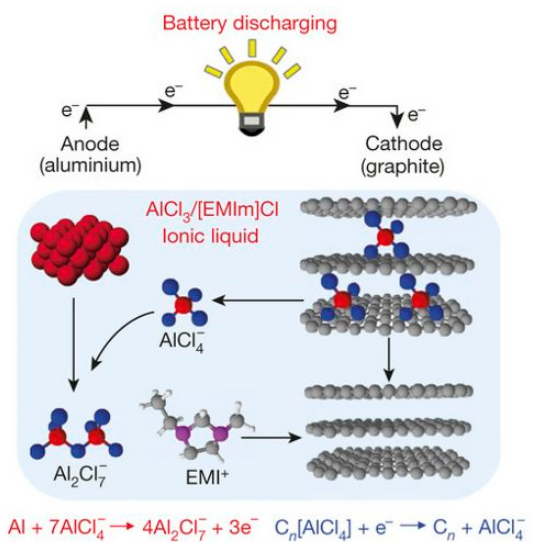
Figure 9. Illustration of the processes occurring in an Al / graphite cell during discharge. (From reference [144] with permission).